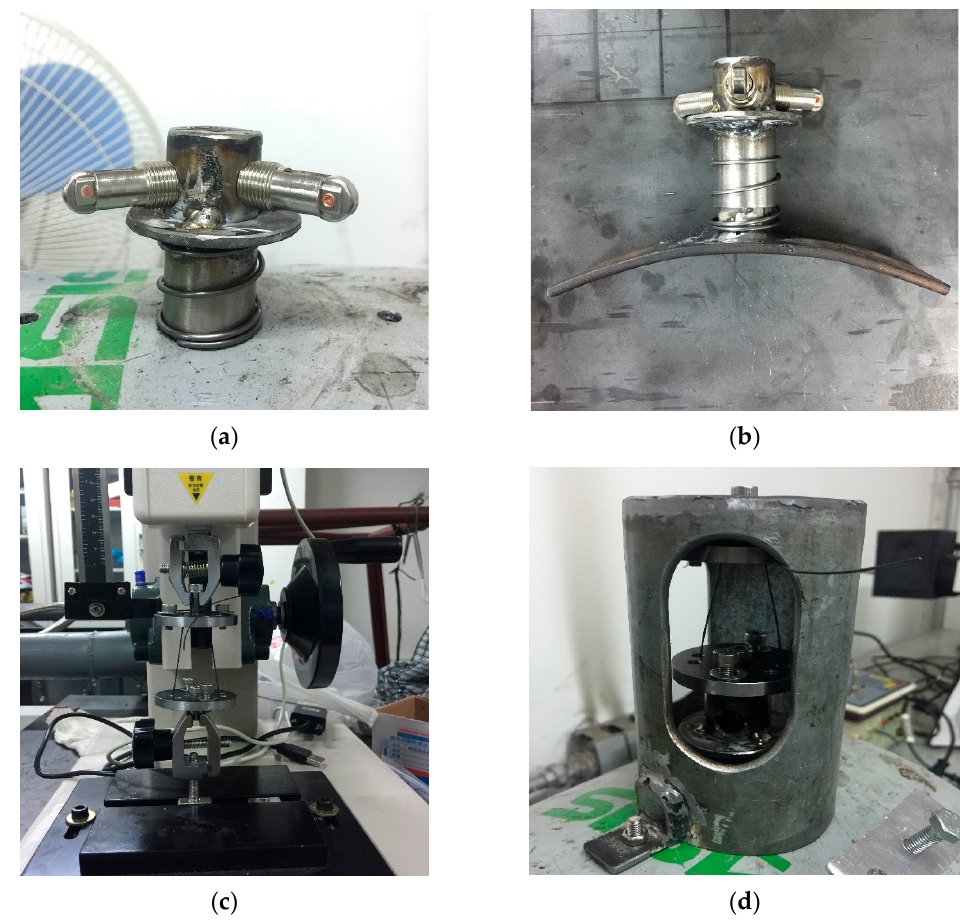
Figure 10. Prototype of the SMA-based actuator: ( a ) Limiter; ( b ) driving lever and internal casing; ( c ) electrode plates; and ( d ) package.